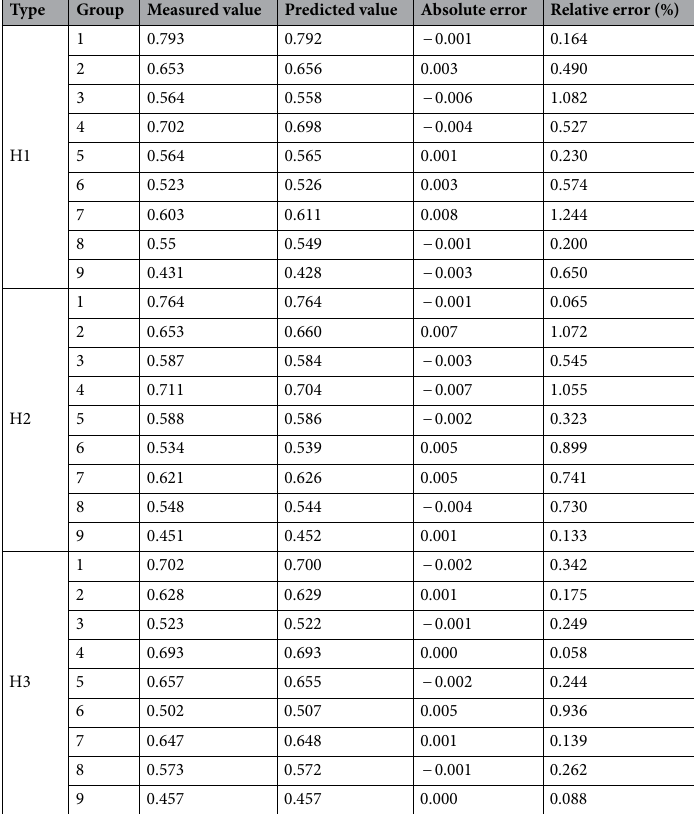
Table 6. Results of PPR models.